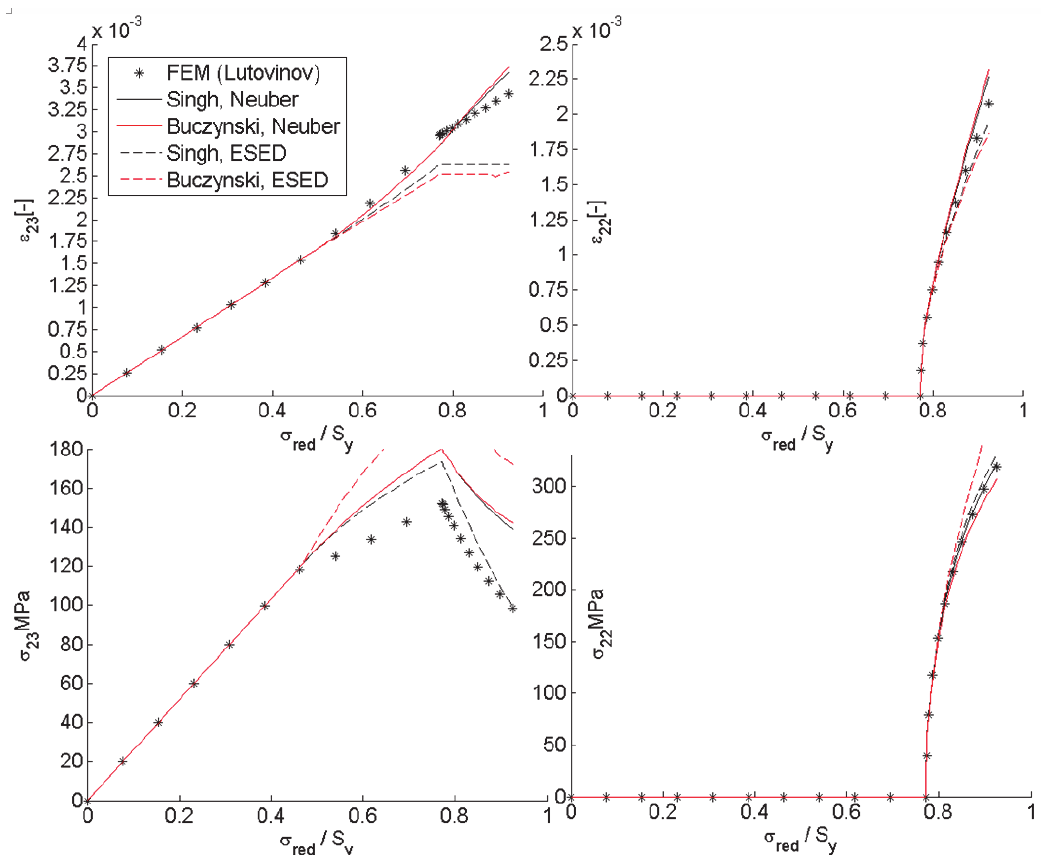
Figure 3: Results of estimations carried out on bar specimen loaded non-proportionally with subsequent tension and torsion [6]. Estimations were performed with the use of cyclic stress–strain curve described by the Ramberg–Osgood